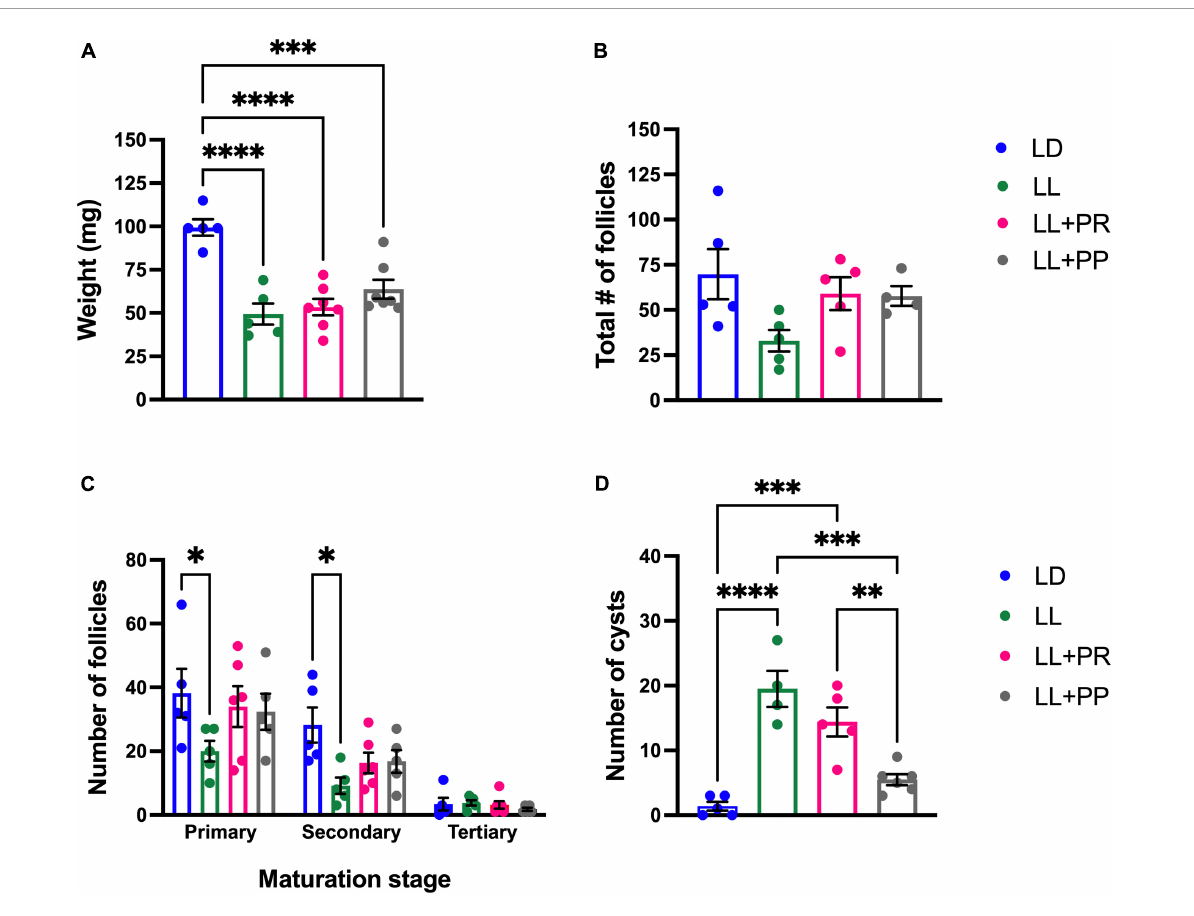
FIGURE9 Ovarian weight and morphology after exposition to constant light (LL) and 12-h food distributed in four pulses events every 3 h. (A) Ovary weight, (B) total number of follicles, (C) number of primary, secondary, and tertiary follicles, and (D) number of cysts. Data are expressed as the mean ± SEM; n = 5–6/group. Asterisks indicate ∗∗∗∗ P <